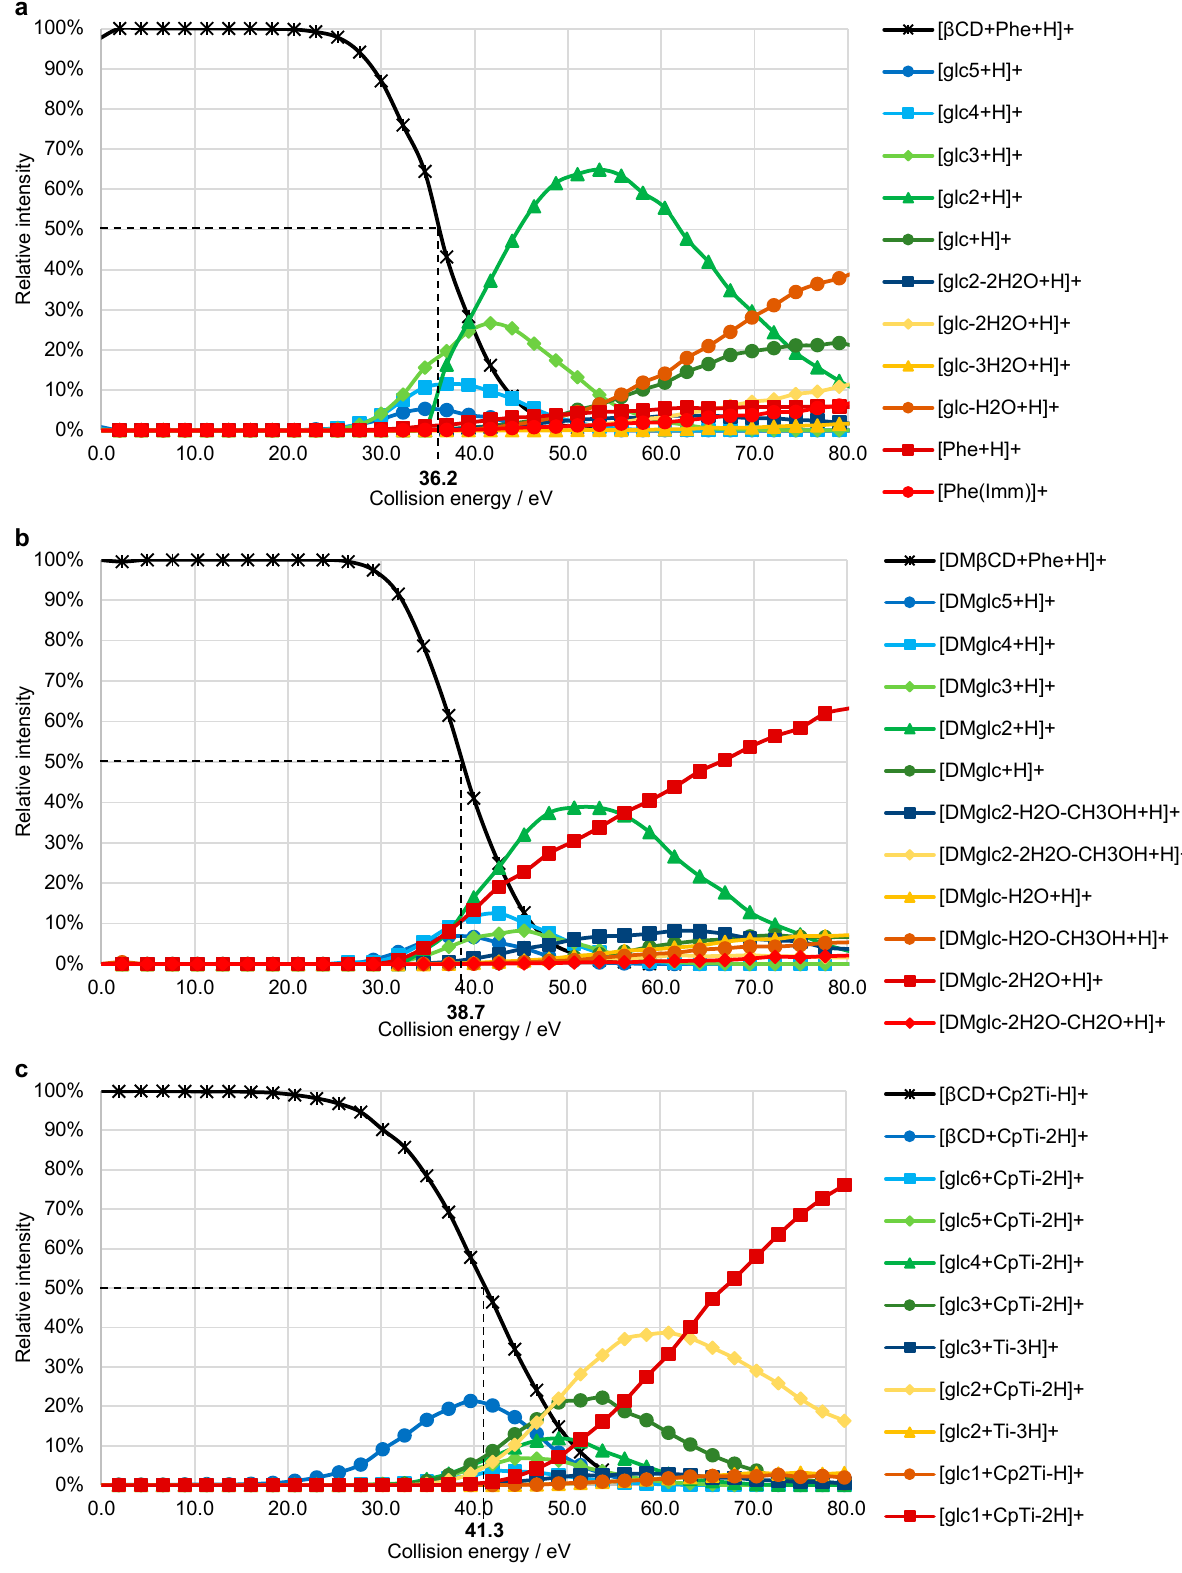
Figure 7. Breakdown curves recorded for HCD experiments of: ( a ) [ β CD + Phe + H] + ( m / z 1300.48), ( b ) [DM β CD + Phe + H] + ( m / z 1496.70), ( c ) [ β CD + Cp 2 Ti–H] + ( m / z 1311.40). Fragment ions with a maximum relative intensity <2% are not dis- played. The dashed lines indicate the CE 50 values.